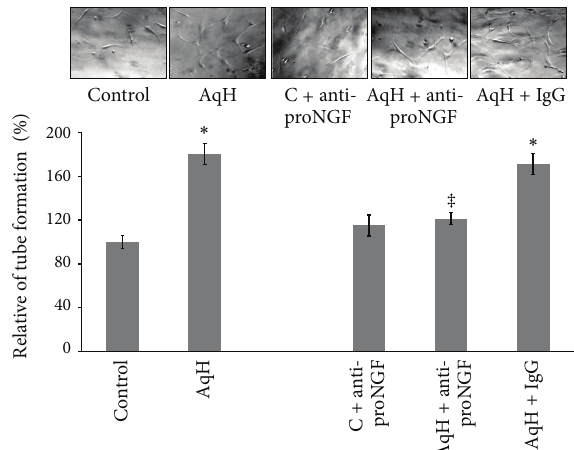
Figure 2: PDR-aqueous humor stimulates tube-like structures in a proNGF-dependent manner. HRE cells were grown into confluence then trypsinized and mixed with reduced-growth factor Matrigel andtreatedwithaqueoushumorsamples(10 𝜇 L/mL)inthepresence or absence of either anti-proNGF antibody or rabbit IgG (1 𝜇 g/mL). Representative micrographs for alignment of HRE into tube-like structures are shown after 18hrs of incubation. Statistical analysis of tube length showed that aqueous humor increased mean tube formation 1.7-fold compared to the control group. Addition of anti- proNGF antibodies to aqueous humor samples significantly reduced the relative mean tube length but did not affect control group. Prior treatment of humor samples with rabbit IgG did not significantly reduce relative mean length when compared to the untreated aq. humor group ( ∗,‡ statistically significant compared to control and aqueous humor groups, resp., ( 𝑃 < 0.05 ), 𝑛 of aqueous humor samples = 7, 𝑛 of cell cultures = 14–16).